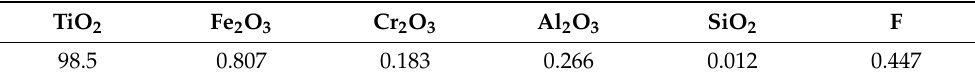
Table 2. The content of the main components in the pyrohydrolysis product of titanium fluorides (600 °C, 5 g), wt%.